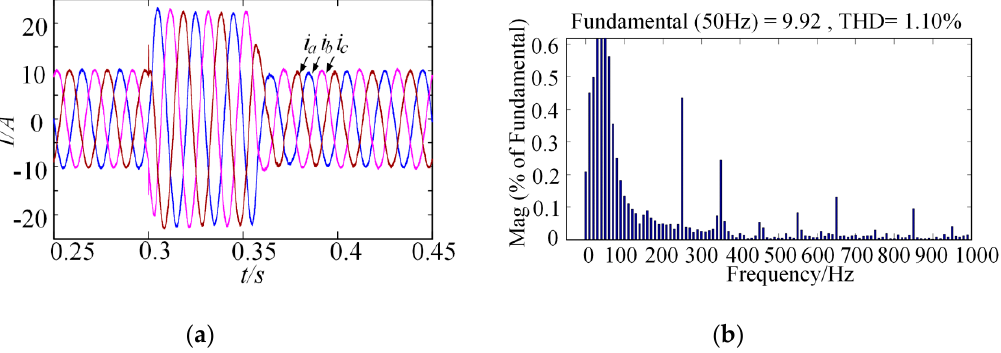
Figure 10. After compensation: ( a ) Grid current; ( b ) Current THD.